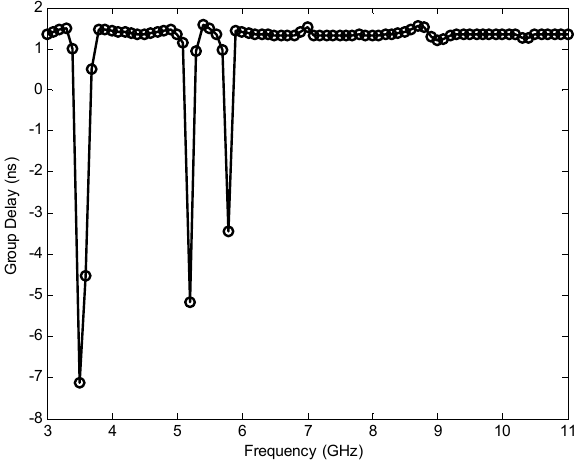
Figure 15. Group delay of the proposed antenna.